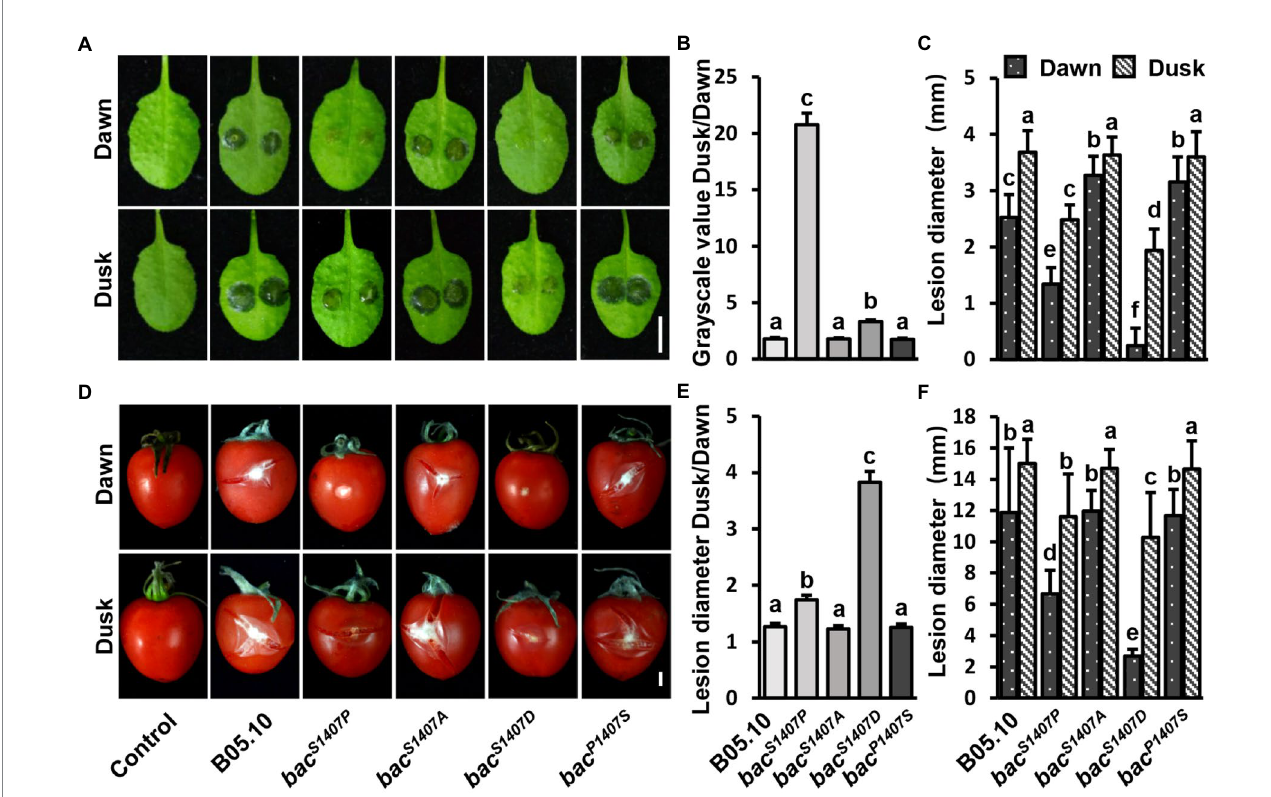
FIGURE 6 Comparison of lesion areas at dawn and dusk during the interaction of B. cinerea and A. thaliana leaves (A) and B. cinerea and tomato fruits (D) . The conidia were cultured under LD conditions. PDB was used to suspend the conidia to 1 × 10 6 conidia/ μ l, the suspension was then placed in the dark for 24 h after inoculation. The white bar represents 5 mm. (B,E) Statistical analysis of contrast of gray values of the lesions recorded at dusk and dawn in (A,D) . (C,F) Statistical analysis of lesion diameter in (A,D) . Different letters indicate significant differences at p < 0.05. The bars present mean values ± SDs ( n =